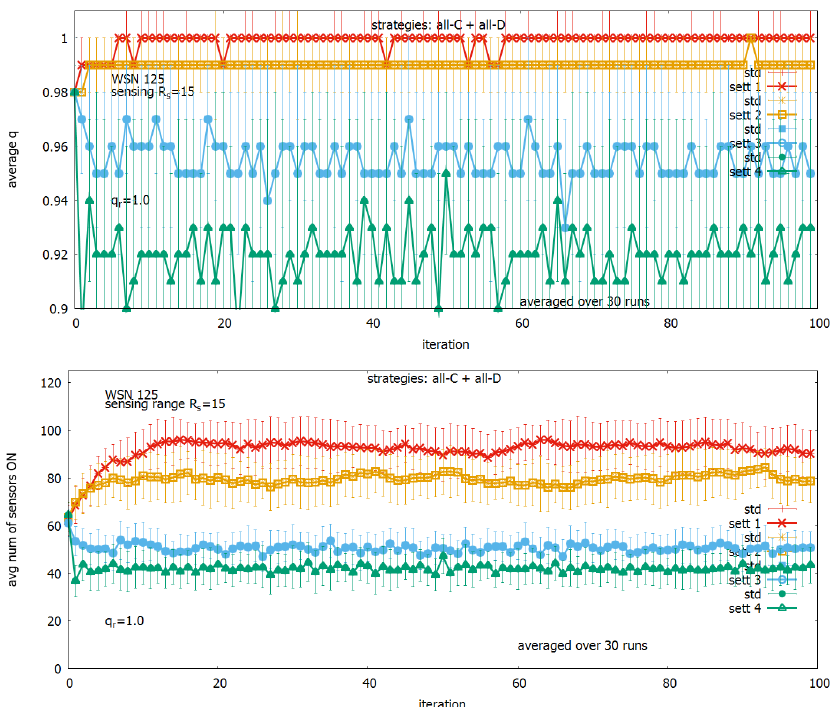
Figure 11. Solutions generated under setting 1, setting 2, setting 3, setting 4 for q r = 1: coverage q ( upper ) and a corresponding number of active sensors ( lower ).